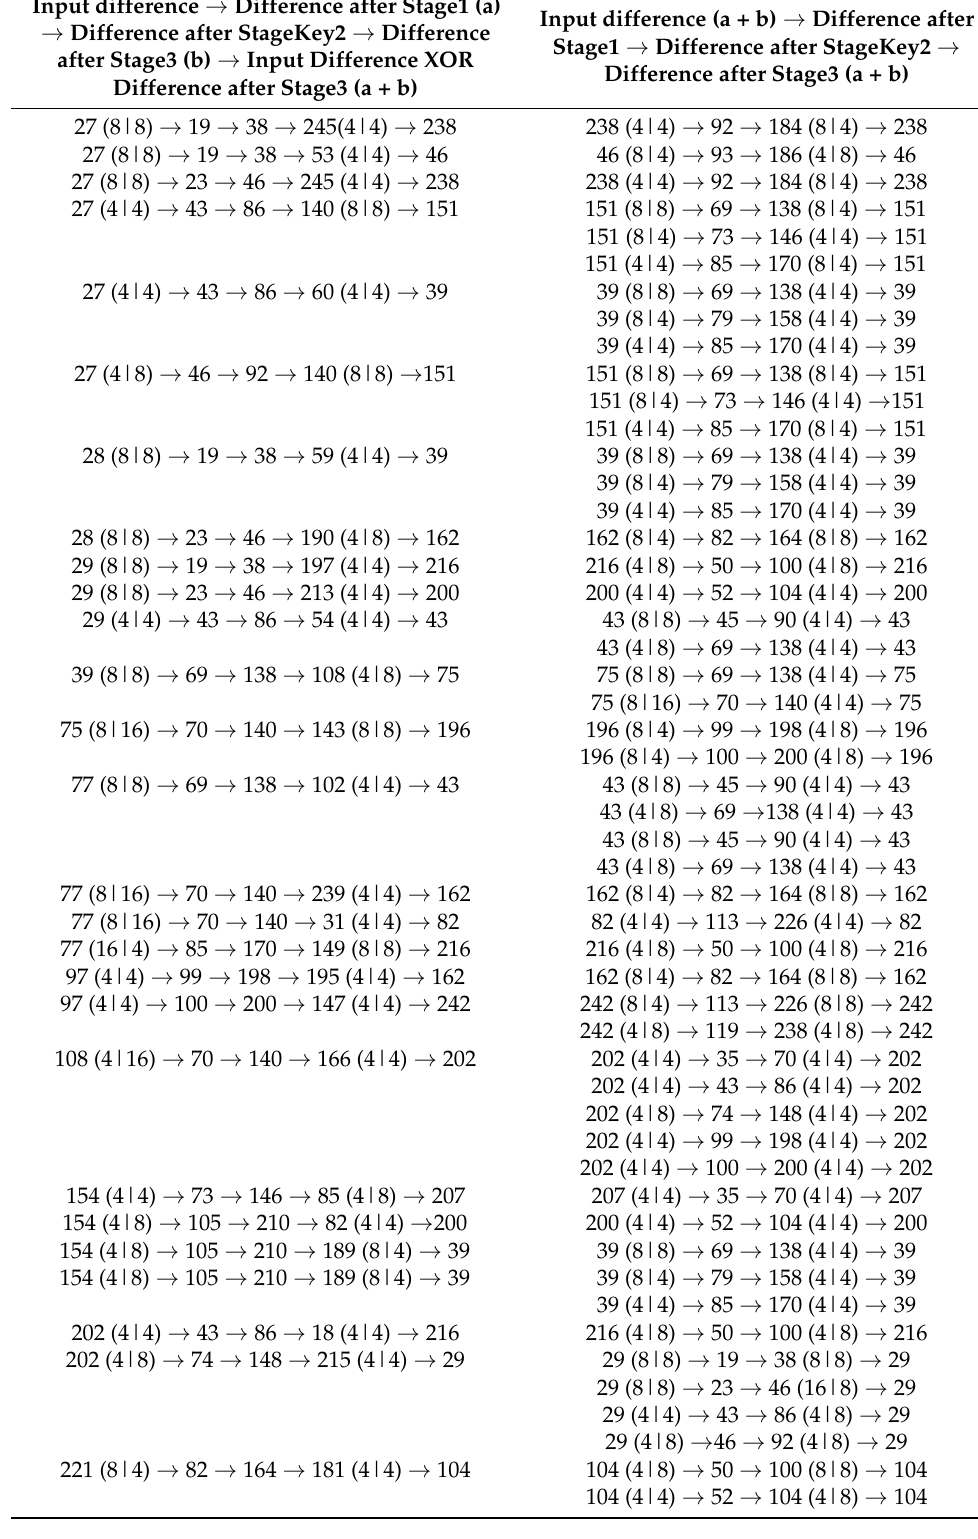
Table 7. Found chains for transforming differences in key